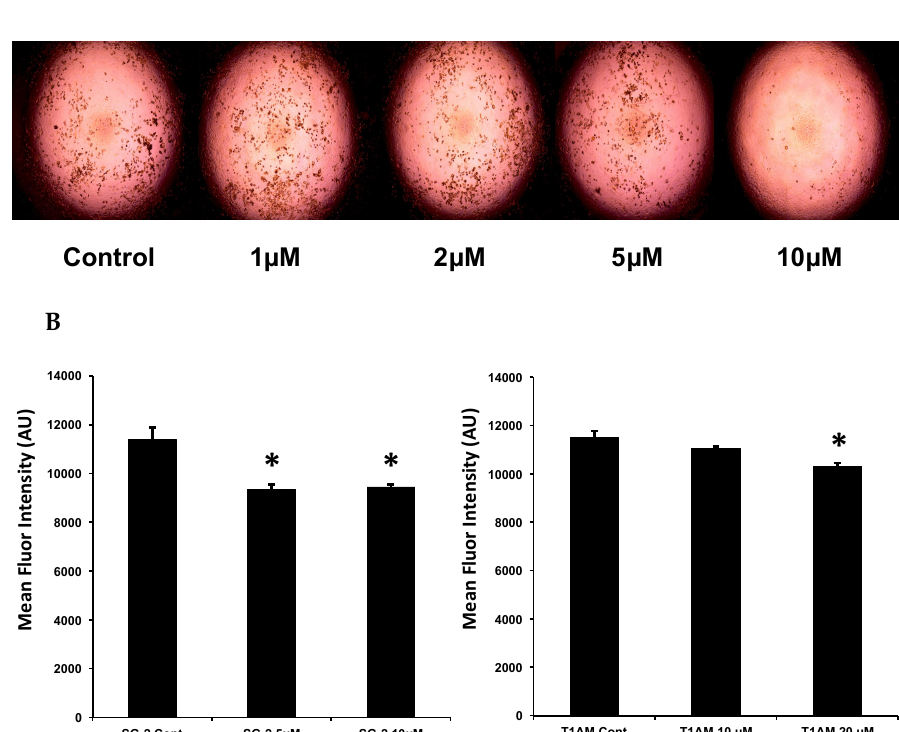
Figure 4. T1AM and SG-2 treatments are associated with decreased lipid accumulation. 3T3-L1 adipocytes were treated with T1AM or SG-2 (1, 2, 5, 10 µ M) at the beginning of di ff erentiation (day 0) ( A ) Visible decreases in lipid accumulation were readily observable at day 5 with SG-2 treatment. Treatment with T1AM did not result in visibly detectible decreases in lipid accumulation (pictures not shown). ( B ) Fluorescent intensity of Nile Red lipid stain in 3T3-L1 di ff erentiated adipocytes treated with 20 µ M T1AM and 10 µ M SG-2 and measured by flow cytometry. Nile red is a fluorescent stain that integrates into and fluoresces when in contact with lipid, allowing for measured fluorescent intensity to correspond to the degree of lipid present in cells. Flow cytometry data are presented as mean channel fluorescence, with +/ − SEM. * denotes a significant di ff erence from control at p < 0.05 (ANOVA Dunnett’s